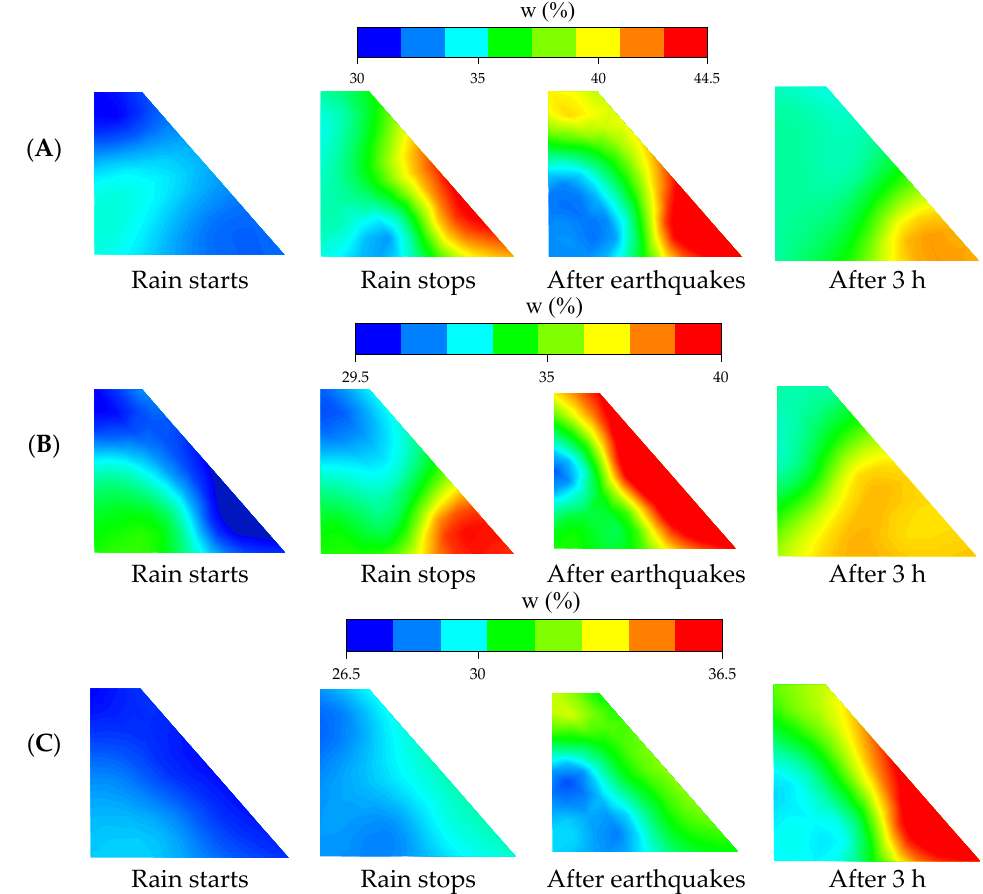
Figure 20. Water content distribution inside model embankments during and after post-rainfall